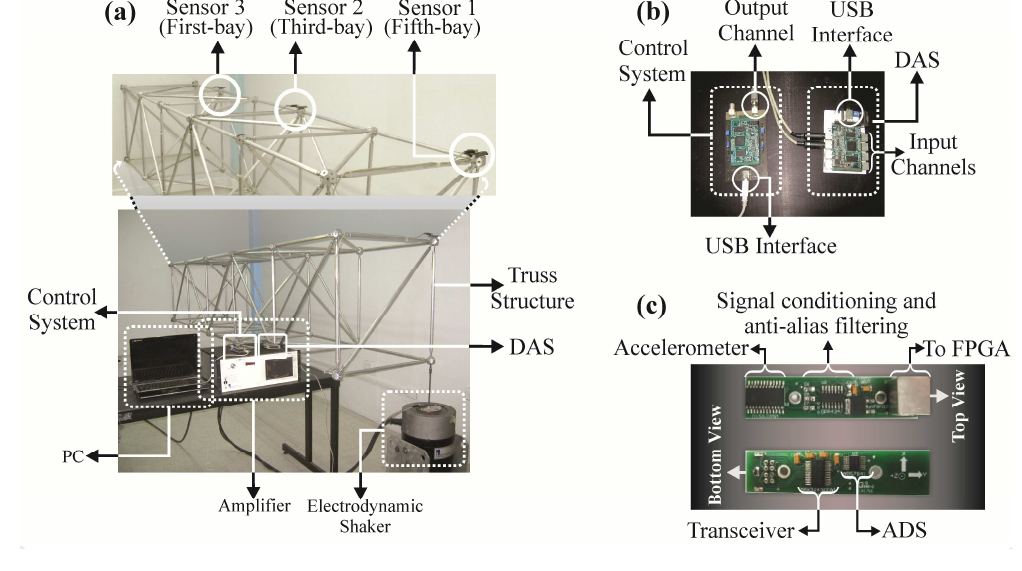
Fig. 7. Experimental setup. Figure 7. Experimental setup. 2